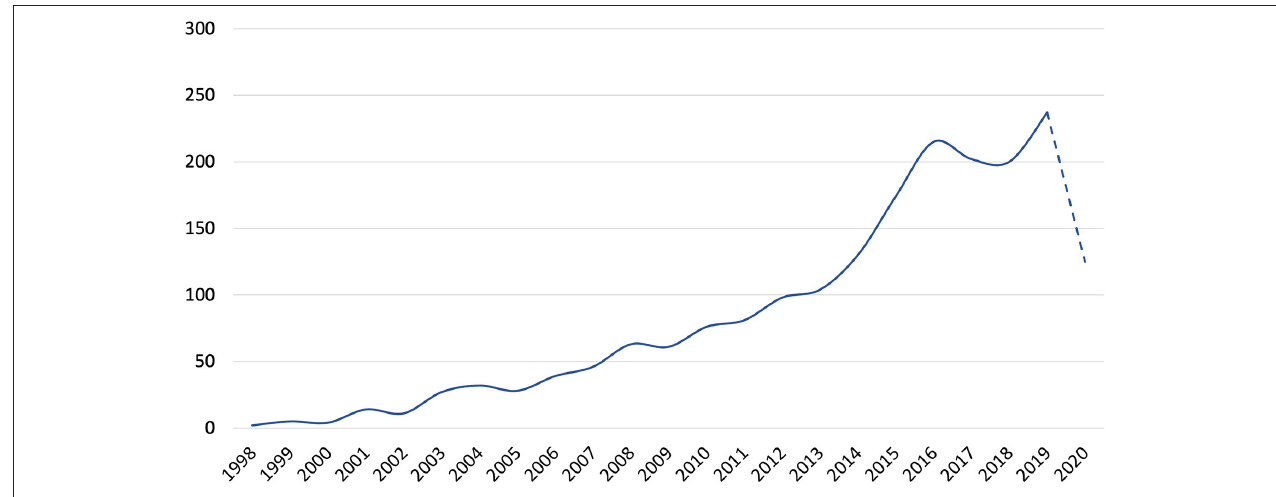
FIGURE 1 | Distribution of the number of published studies related to online health information seeking behavior.